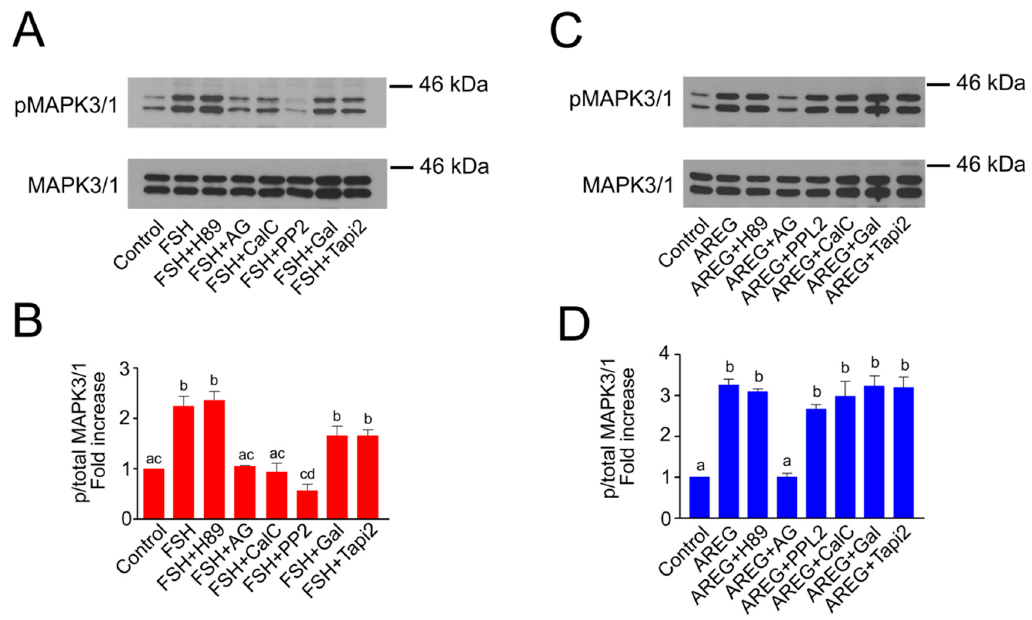
Figure 2. Effect of protein kinase and proteinase inhibitors on FSH- and AREG-induced rapid activation of MAPK3/1 in pig COCs. The panels show representative results of the immunoblotting of phosphorylated and total MAPK3/1 in samples of 25 COCs cultured in vitro for 10 min. The experiments were repeated three times. Quantification of the activated MAPK3/1 was performed by densitometry and is shown in the graphs as proportions of phosphorylated and total MAPK3/1, and expressed in arbitrary units as the fold increase over the proportion found in unstimulated COCs at the beginning of the culture. ( A , B ) show COCs stimulated by FSH; ( C , D ) show COCs stimulated by AREG. The different superscripts above the columns ( D ) or superscripts with no common letters ( B ) indicate significant differences ( p < 0.05). AG: AG1478; CalC: calphostin C; Gal: galardin.